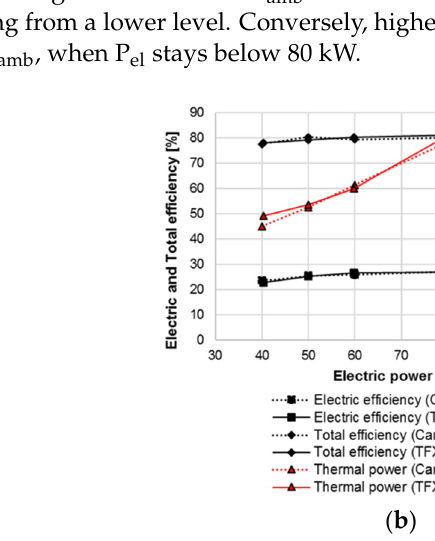
Figure 4. Model validation: effects of part ‐ load operation at non ‐ ISO conditions: ( a ) T amb = 8 °C; ( b ) T amb = 30 °C [33].